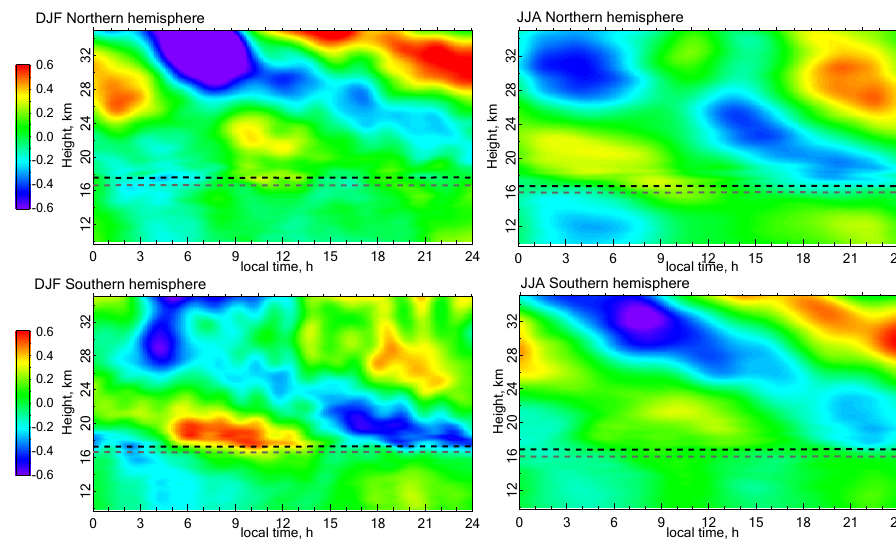
Fig. 1. Zonally averaged temperature diurnal anomalies in the northern (top) and southern (bottom) tropical belts (25 ◦ N–0 ◦ and 0–25 ◦ S) in DJF (left) and JJA (right). Black and gray dashed lines denote mean CPT and LRT levels respectively.